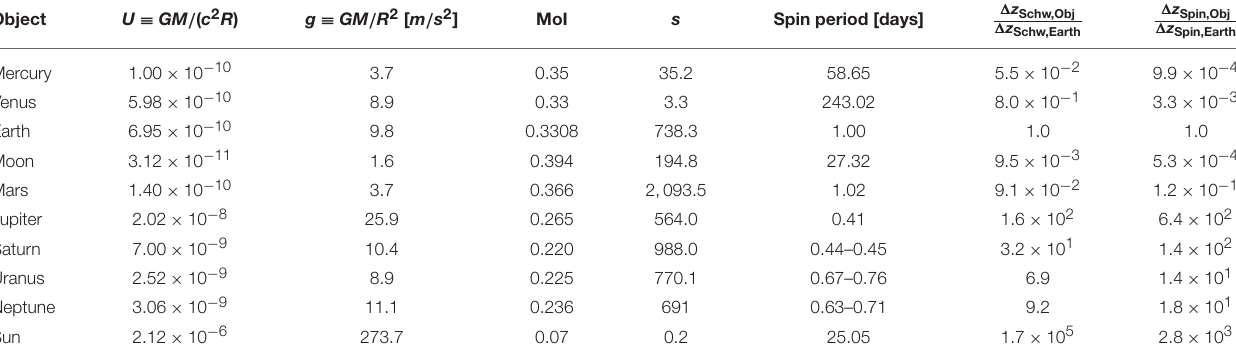
TABLE 1 | Gravitational and spin parameters for the planets and the Moon.